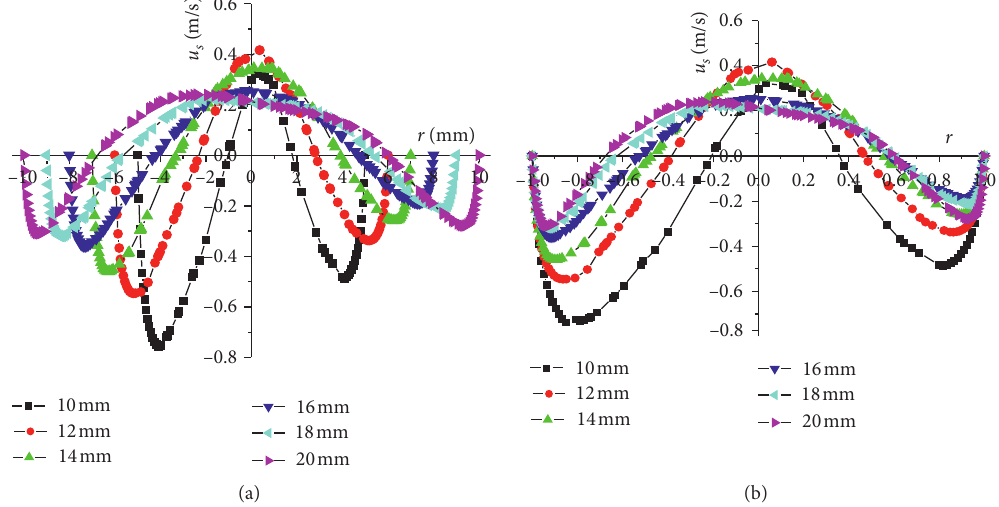
Figure 10: Axial velocity distribution of Y 3 section at different cylinder diameters. (a) Absolute radial quantity. (b) Radial